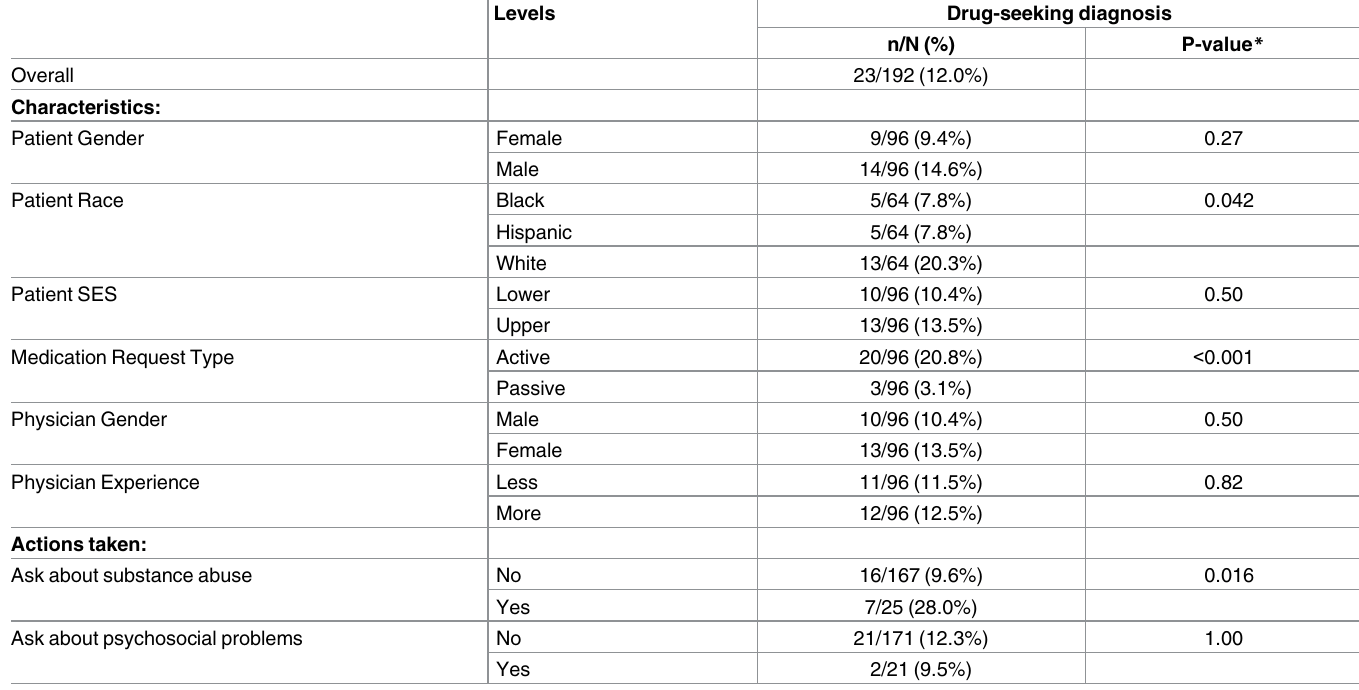
Table 2. Rates of drug-seeking diagnosis and associated actions for the sciatica